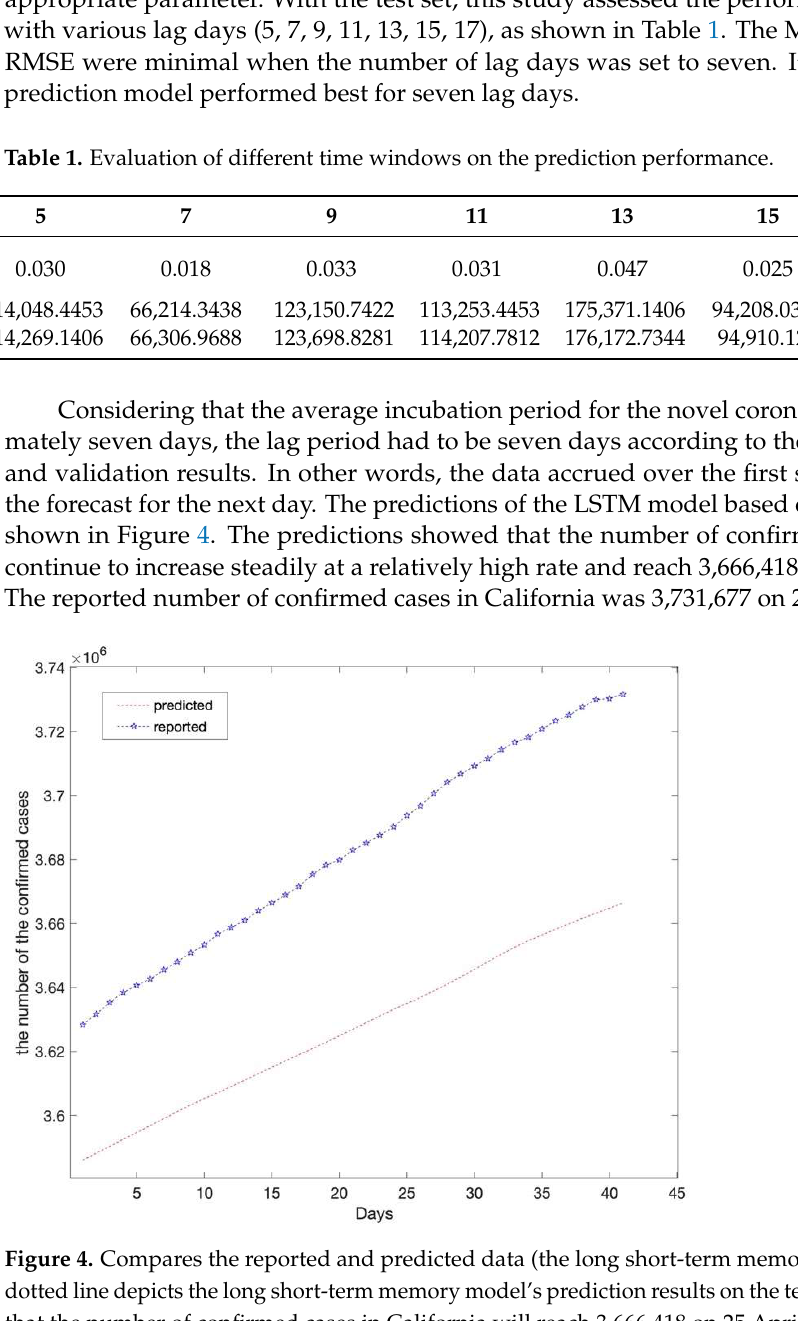
Table 1. Evaluation of different time windows on the prediction